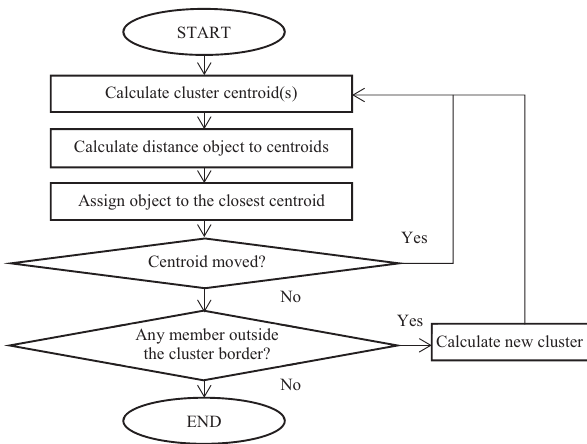
Figure 3. K-Means progressed clustering flowchart